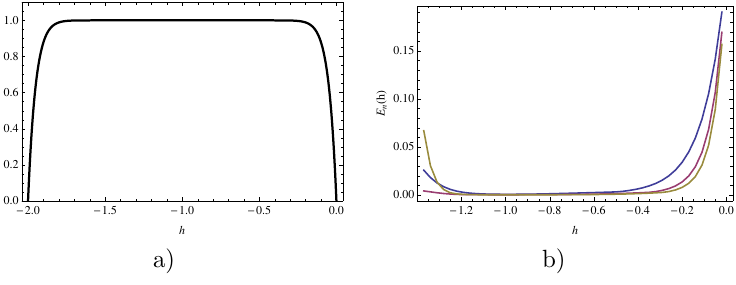
Figure 7. The h -curve ( a ) and squared residual E n ( h ) ( b ) for n = 5 , 8 , 10 (the successive curves from the top) Now the optimum value of the convergence control parameter h is equal to − 0 . 47. The h -curve and square residual are presented in Figure 7. As